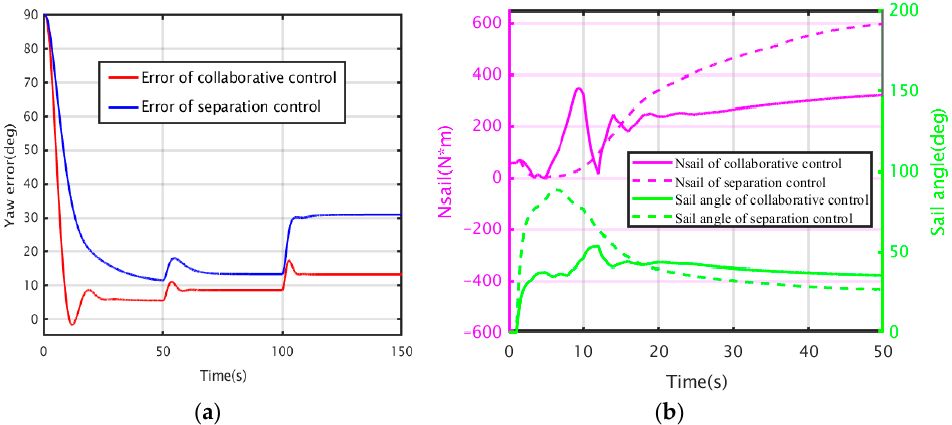
Figure 5. ( a ) Comparison curves of yaw angle error for sidewind navigation; ( b ) Comparison curves of sail angle and turning yaw moment for sidewind sailing.